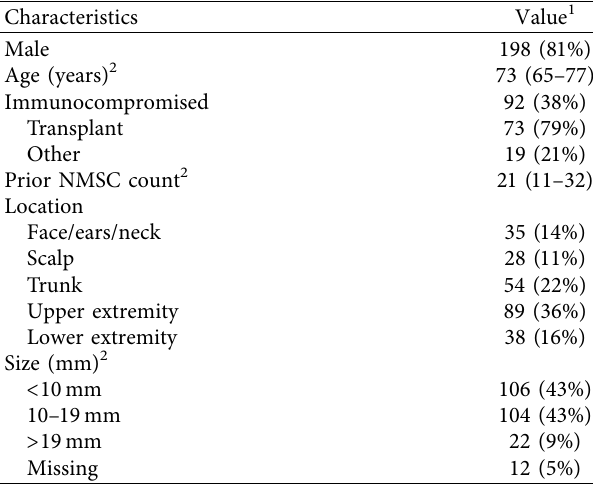
Table 1: Descriptive characteristics of 244 lesions among 63